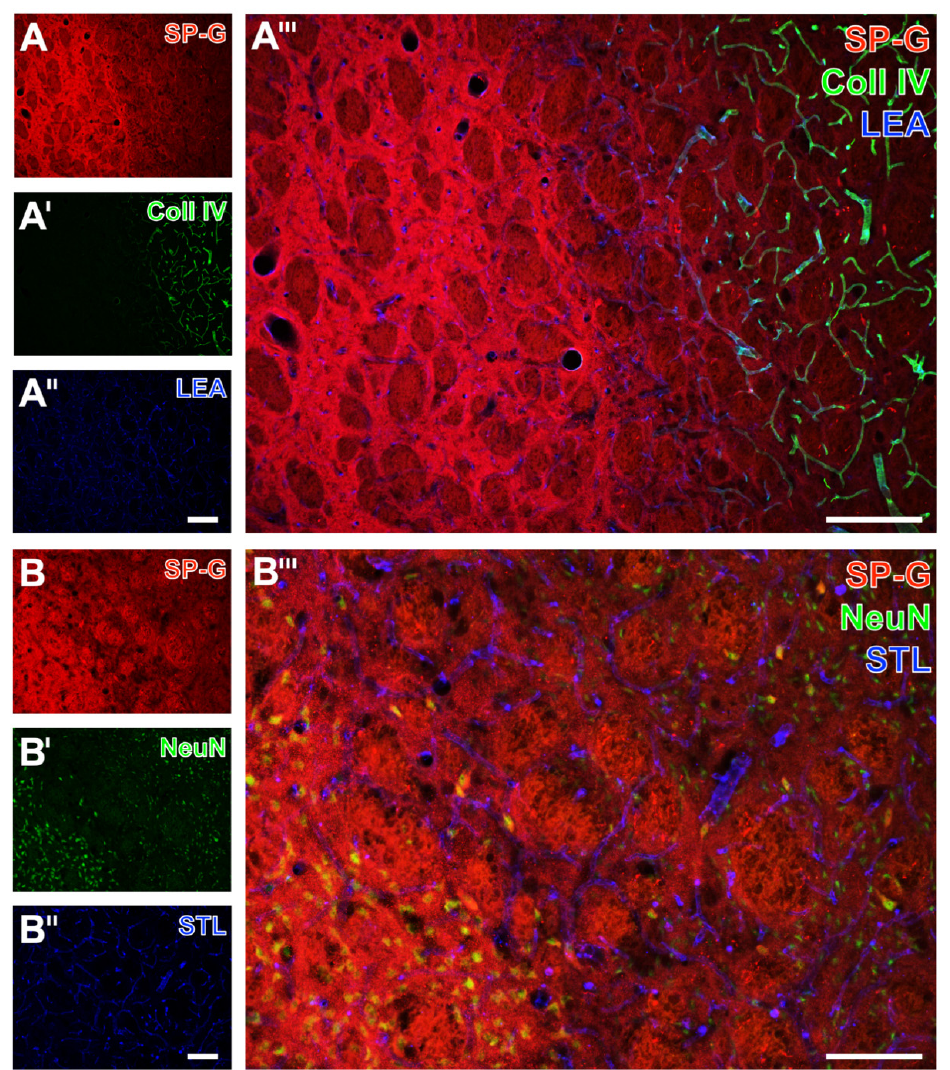
Figure 9. Regional associations of surfactant protein-G (SP-G), vascular elements, and neurons after focal cerebral ischemia in rats. Representative triple fluorescence labeling of SP-G, collagen (Coll) IV, and vascular binding sites for Solanum tuberosum lectin (STL) in the affected striatum after 24 h of focal cerebral ischemia ( A – A”’ ). Exemplary combined fluorescence-based detection of SP-G, the neuronal marker NeuN and STL-stained endothelia in the ischemia-affected striatum of a rat subjected to 24 h of focal cerebral ischemia ( B – B”’ ). Scale bars: A” (also valid for A and A’ ) = 200 µ m, A”’ = 200 µ m, B” (also valid for B and B’ ) = 100 µ m, B”’ = 100 µ